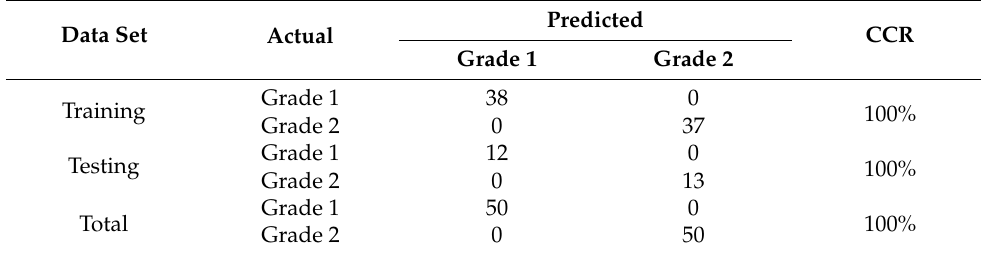
Table 4. The confusion matrix of the SVM classifier. Grades 1 and 2 represent the number of high- and low-quality samples, respectively.